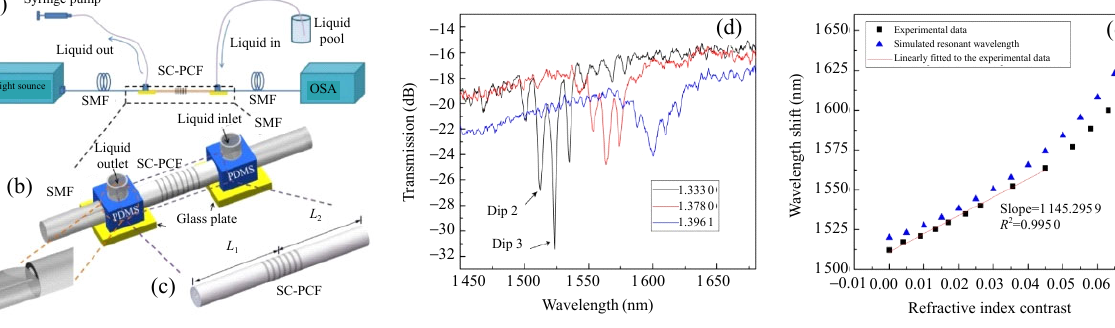
Refractive index contrast